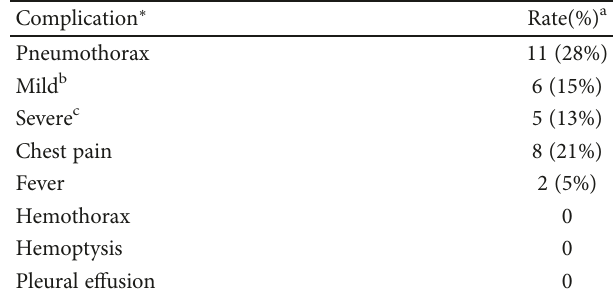
Table 2: Complications of 39 times